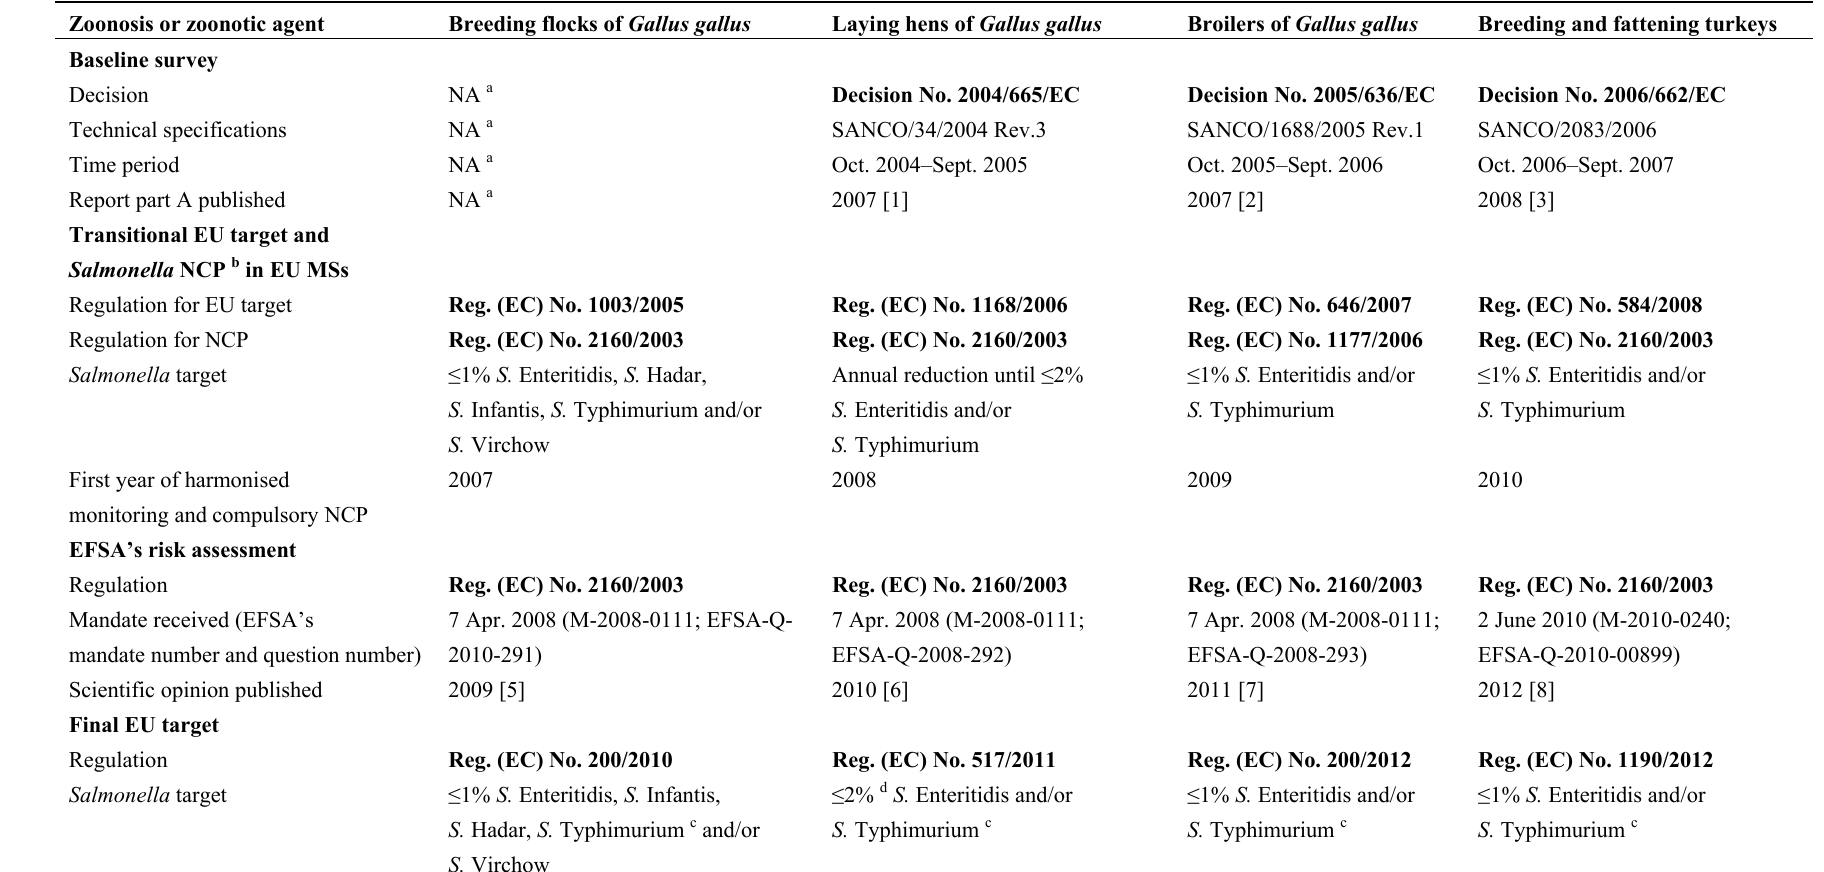
Table 1. Timelines of setting Salmonella targets at the EU level in flocks of poultry populations and related regulatory